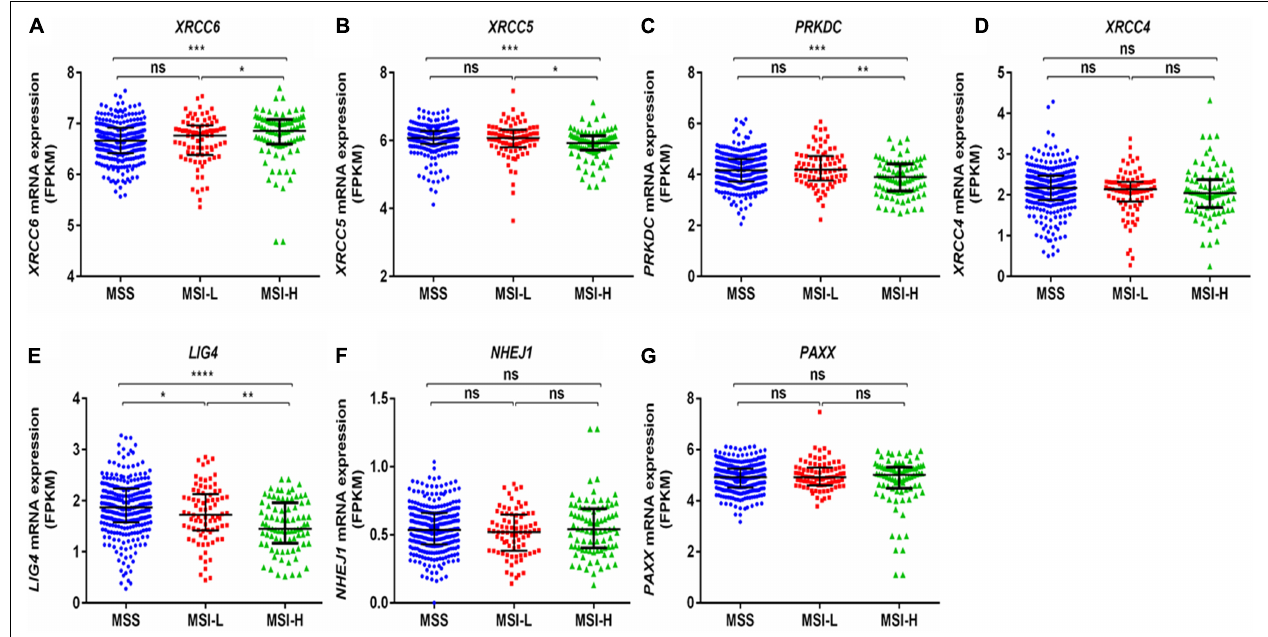
FIGURE 5 | Comparison of mRNA expression of NHEJ pathway genes based on microsatellite instability status from TCGA-COAD dataset. (A) XRCC6 (B) XRCC5 (C) PRKDC (D) XRCC4 (E) LIG4 (F) NHEJ1, and (G) PAXX. FPKM, Fragments per kilo million bases. MSI-H, MSI-high; MSI-L, MSI-low; MSS, microsatellite stable. * p < 0.05, ** p < 0.01, *** p < 0.001, **** p <